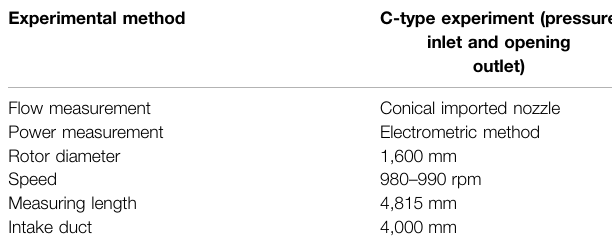
TABLE 2 | Parameters of experimental